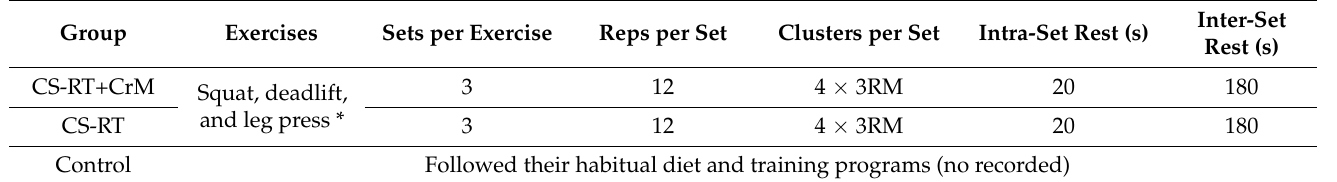
Table 1. Eight-week cluster-set resistance training